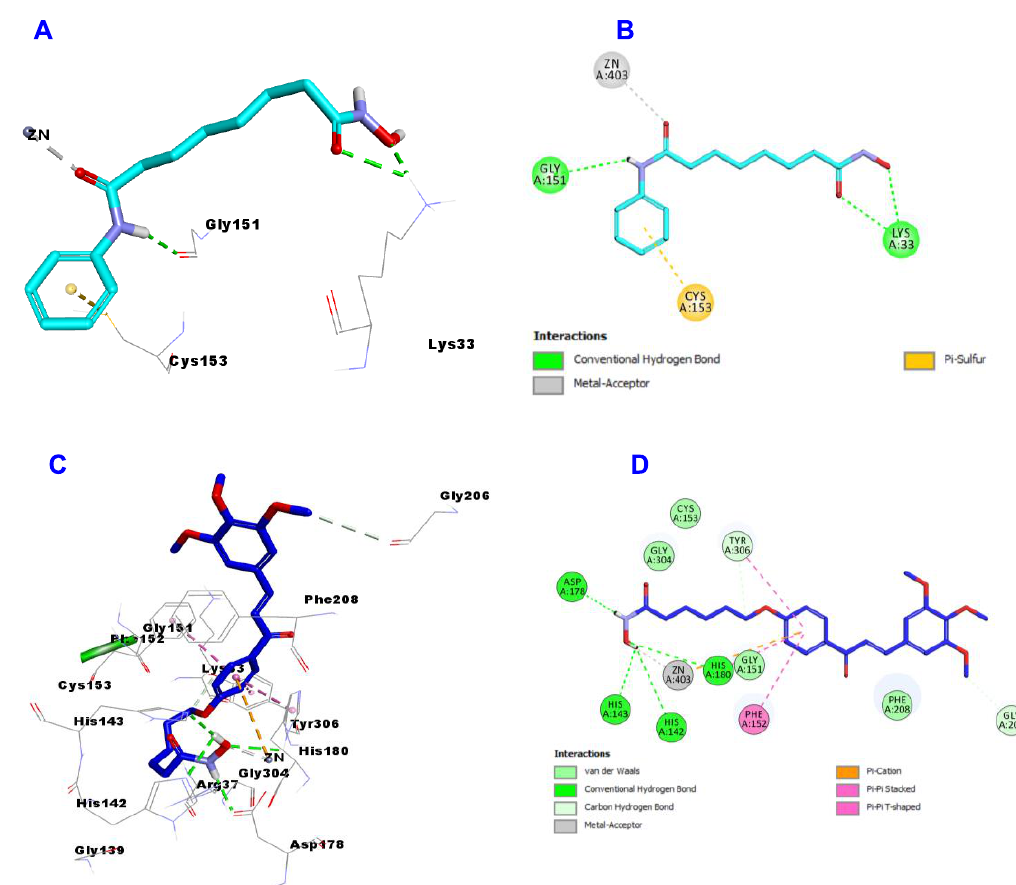
Figure 11. Docking and binding mode of SAHA (cyan) and 4b (blue) into the active site of HDAC 8 (PDB entry: 3SFH); ( A ) 3D structure of SAHA , ( B ) 2D structure of SAHA , ( C ) 3D structure of 4b , ( D ) 2D structure of 4b .